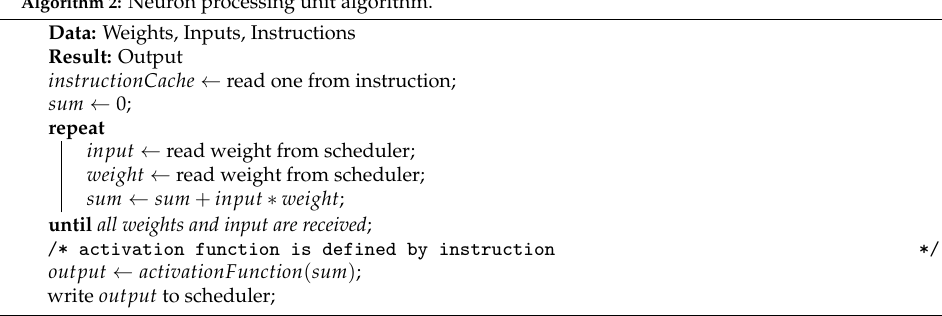
Algorithm 2: Neuron processing unit algorithm.